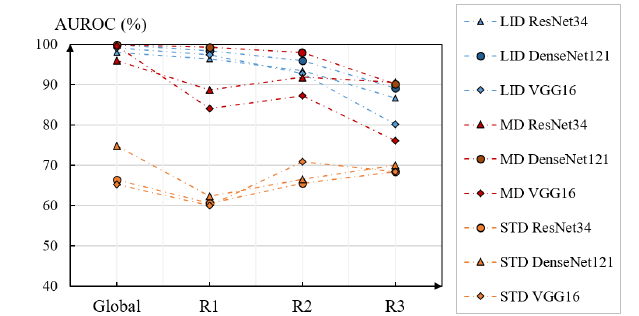
Figure 2. Influence of regional constraints on detection performance against CW adversarial examples. The area under the receiver operating characteristic curve (AUROC) is used as a metric to measure the detection